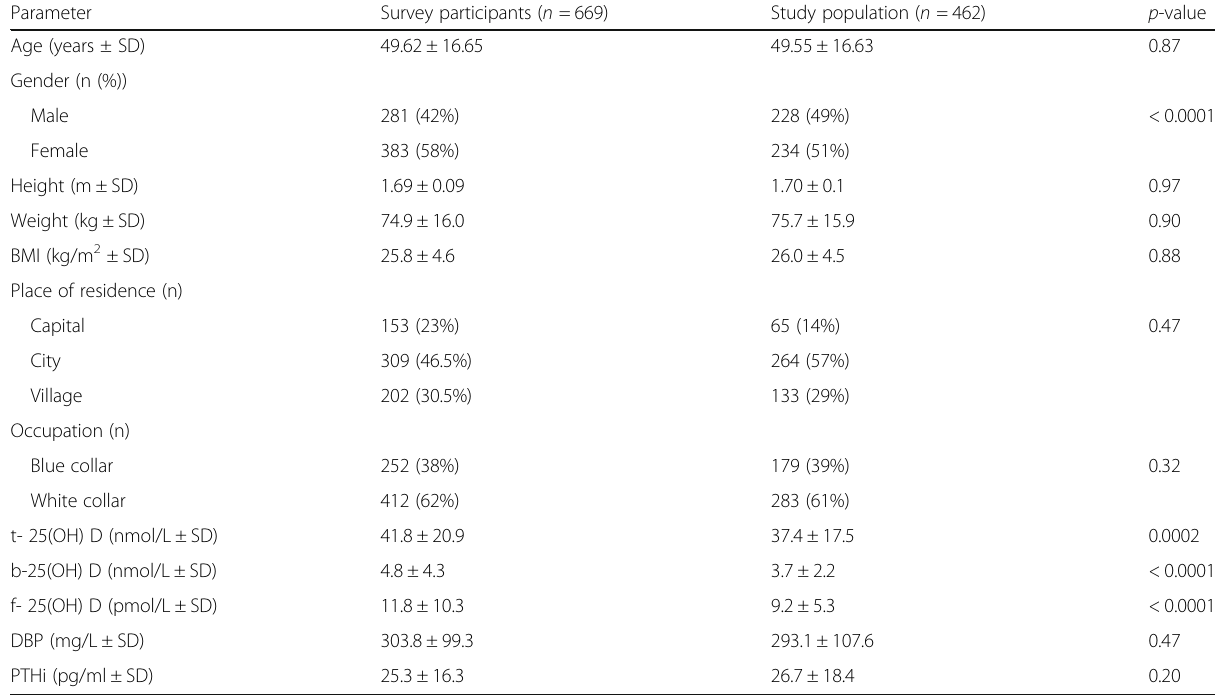
Table 1 Characteristics of the full survey and the genetic substudy population Parameter Survey participants ( n =